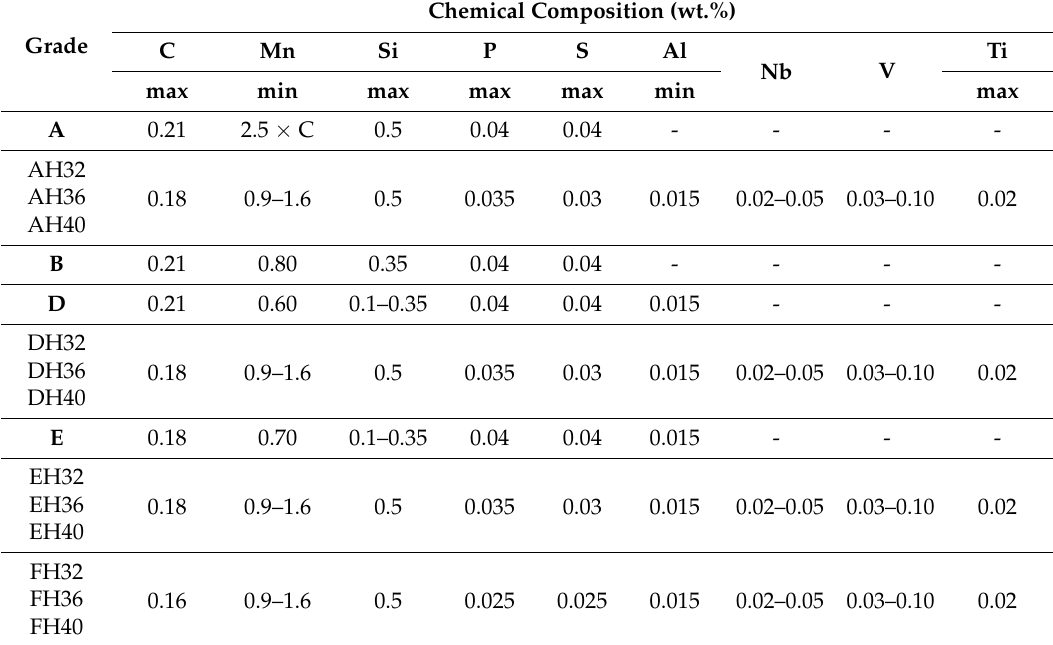
Table 2. Nominal chemical composition of “Normal medium tensile ship” steel grades to Lloyd’s Rules: as-rolled, normalized, normalizing rolled or thermomechanically processed [32].